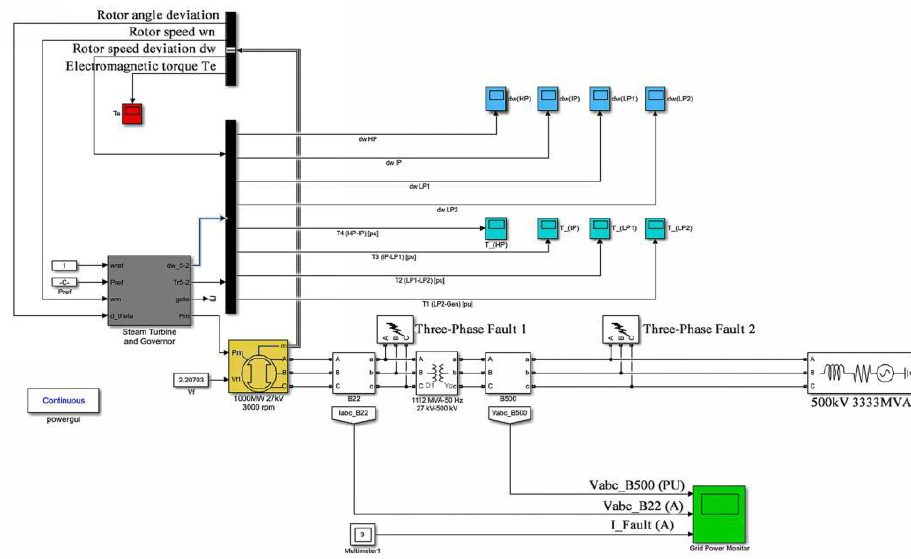
Figure 2. Short-circuit fault simulation circuit system.